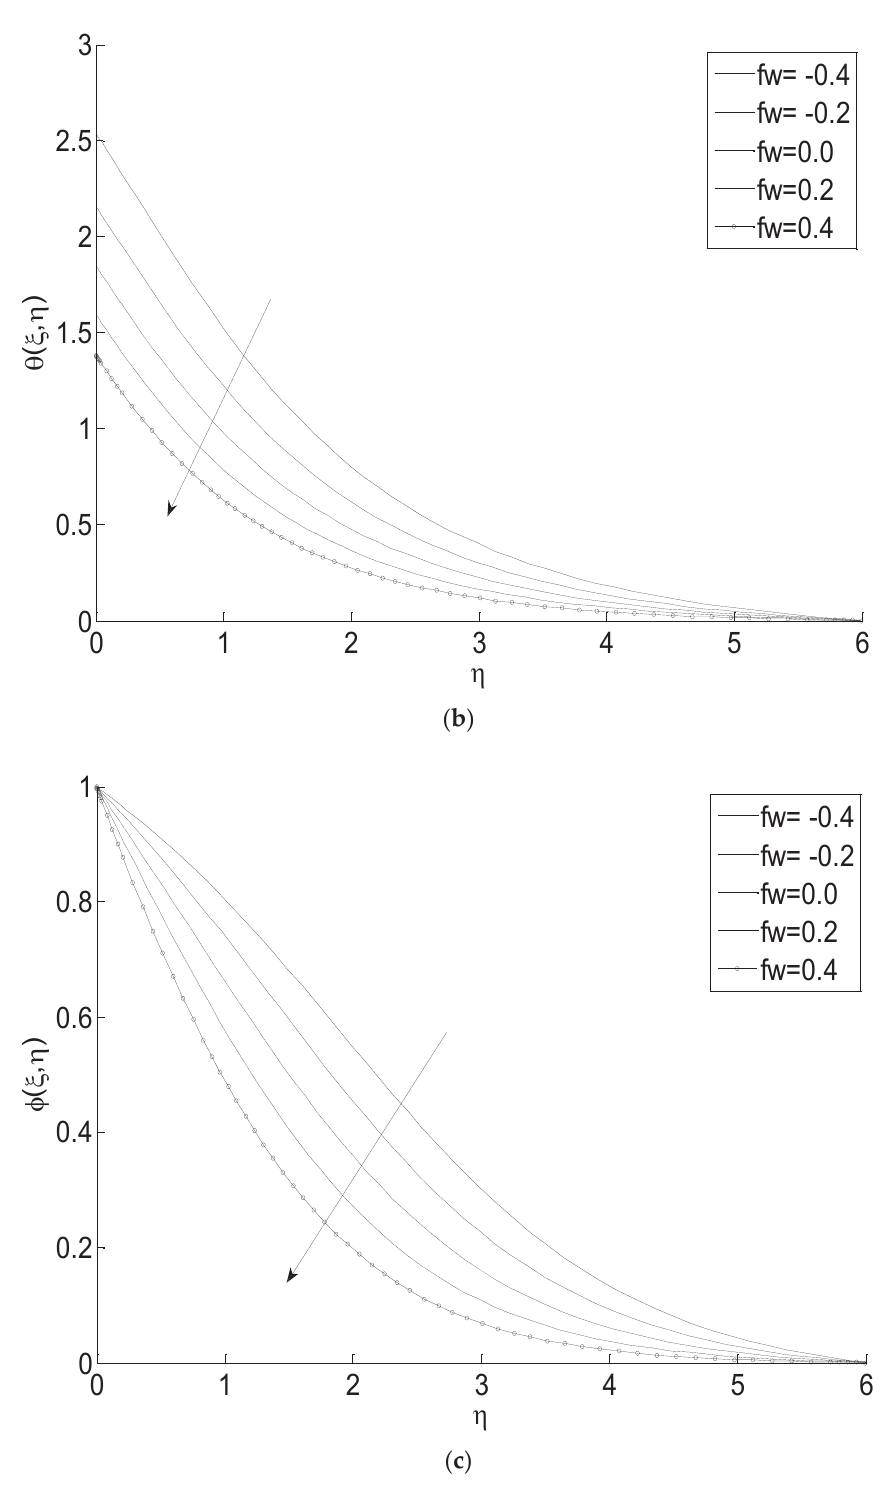
Figure 2. ( a – c ) Velocity, temperature, and concentration profiles, respectively, with different suc- tion/blowing parameters at ξ = 1.0, n = 1.0, Sc = 1.0, N = 1.0, γ = 2.01, ε = 0.45, κ = 0.5, and Nt = 1.0.